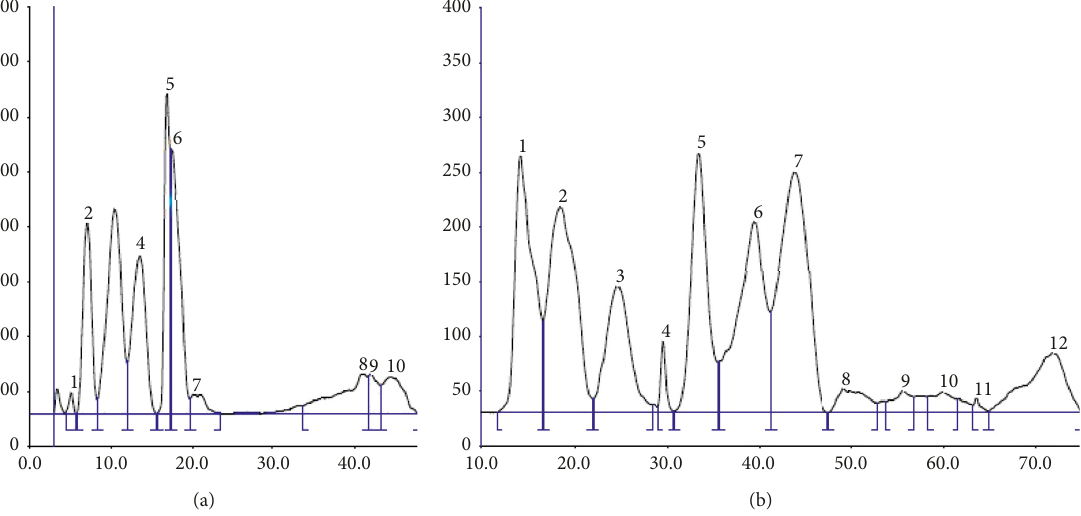
Figure 6: Separation of the mixture of flavonoids and phenolic acids with the use of HPTLC (a) and PPEC (b) techniques. Experiment conditions: the mobile phase: butanol 1.2M, acetonitrile 10% v/v, aqueous buffer of pH 7.0 (0.88 mM of citric acid and 8.23mM of disodium hydrogen phosphate), and 0.040M of SDS; the stationary phase: HPTLC RP-18W. PPEC: polarization voltage 1400V; experiment time 8min; experiment temperature 38 o C. The order of solutes for HPTLC: (1) rutin, (2) hesperidin; (3) trans -cinnamic acid and hesperidin; (4) caffeic acid and o -coumaric acid; (5) flavanone; (6) vanillic acid. The order of compounds in the PPEC experiment: (1) flavanone; (2) trans - cinnamic acid and hesperetin; (3) o -coumaric acid; (4) rutin; (5) hesperidin; (6) vanillic acid; (7) caffeic